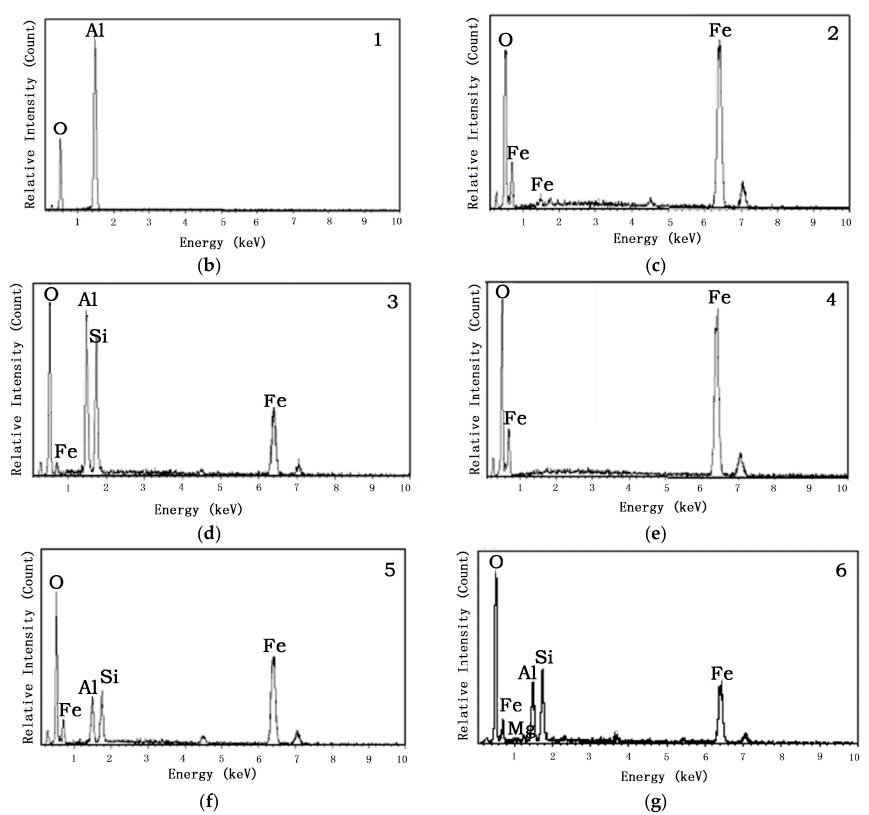
Figure 2. ( a ) SEM image of ferric bauxite; ( b ) EDS image of point 1; ( c ) EDS image of point 2; ( d ) EDS image of point 3; ( e ) EDS image of point 4; ( f ) EDS image of point 5 and ( g ) EDS image of point 6. Table 1. Chemical composition of ferric bauxite.